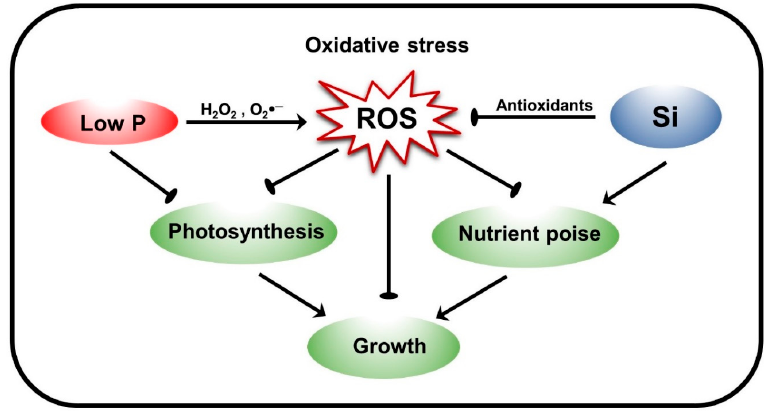
Figure 6. A working model showing potential mechanisms of Si-induced alleviation of low P stress in tomato: Low P stress induces oxidative stress by triggering reactive oxygen species (ROS) accumulation, leading to impairment in photosynthesis and nutrient homeostasis. Suppression in photosynthesis and nutrient acquisition due to deficient P supply results in growth inhibition; however, exogenous Si application reduces ROS accumulation and subsequent oxidative stress by enhancing antioxidant potential. Moreover, Si improves photosynthesis and essential nutrient acquisition, which eventually stimulate plant growth and biomass accumulation.